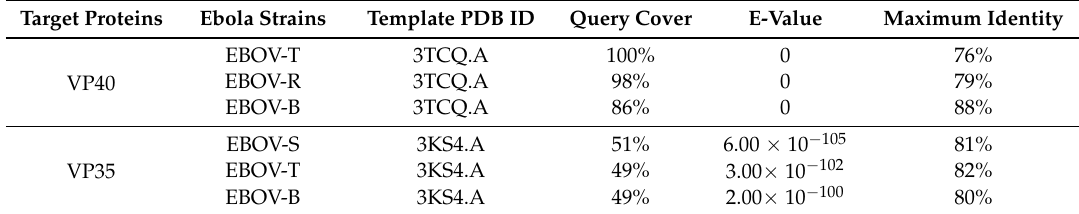
Table 4. Homology modelling of EBOV different